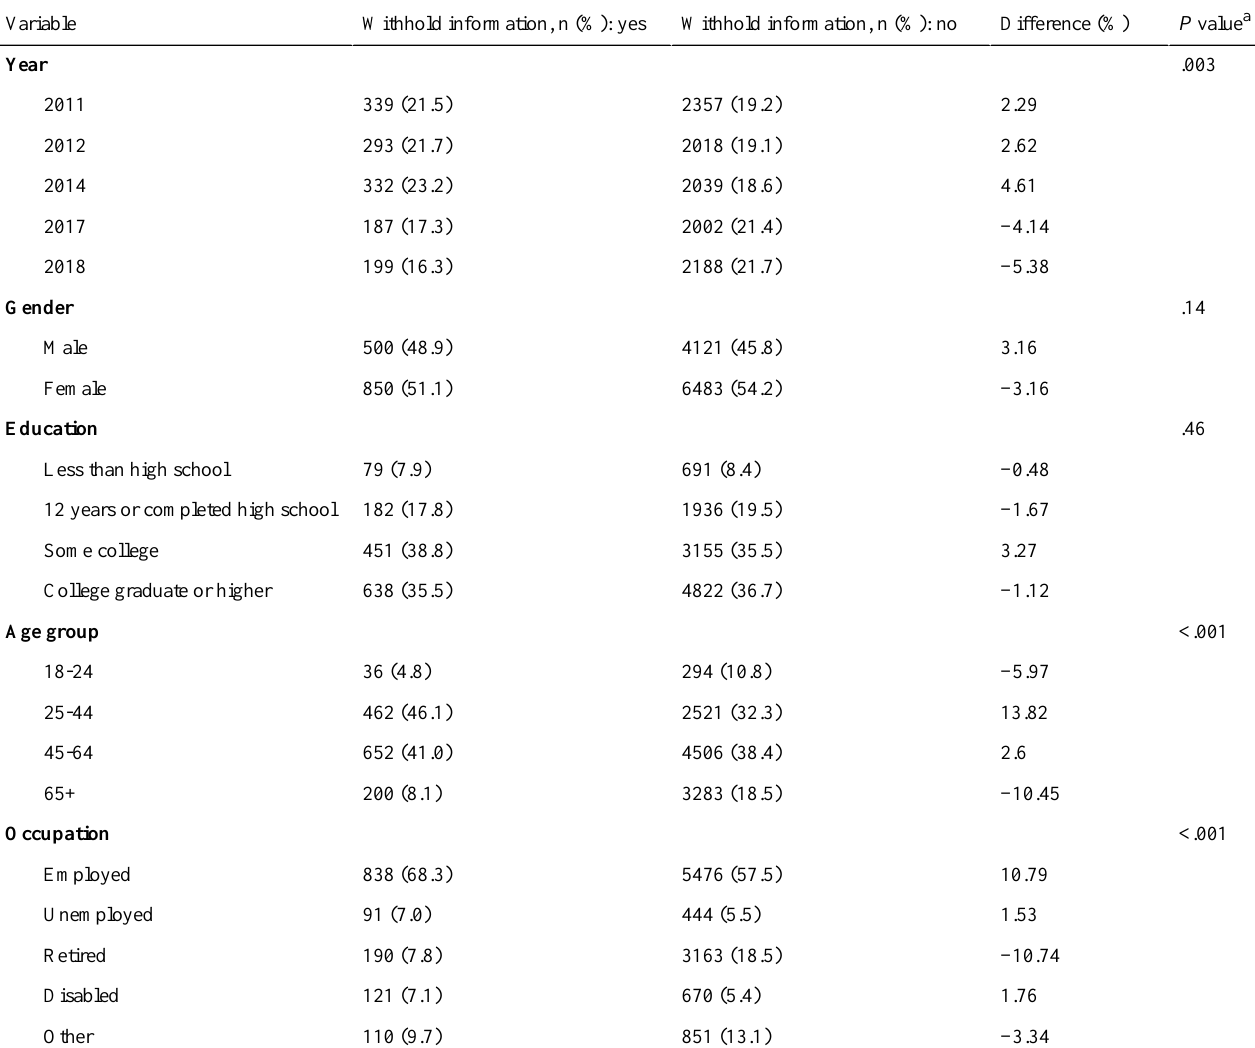
Table 1. Sample characteristics of the nationally representative sample across 5